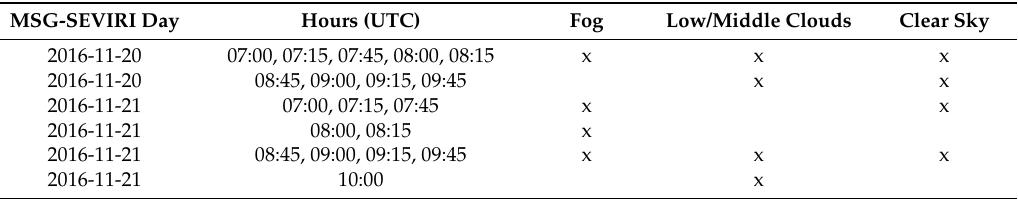
Table 3. Scenes used for accuracy calculation.